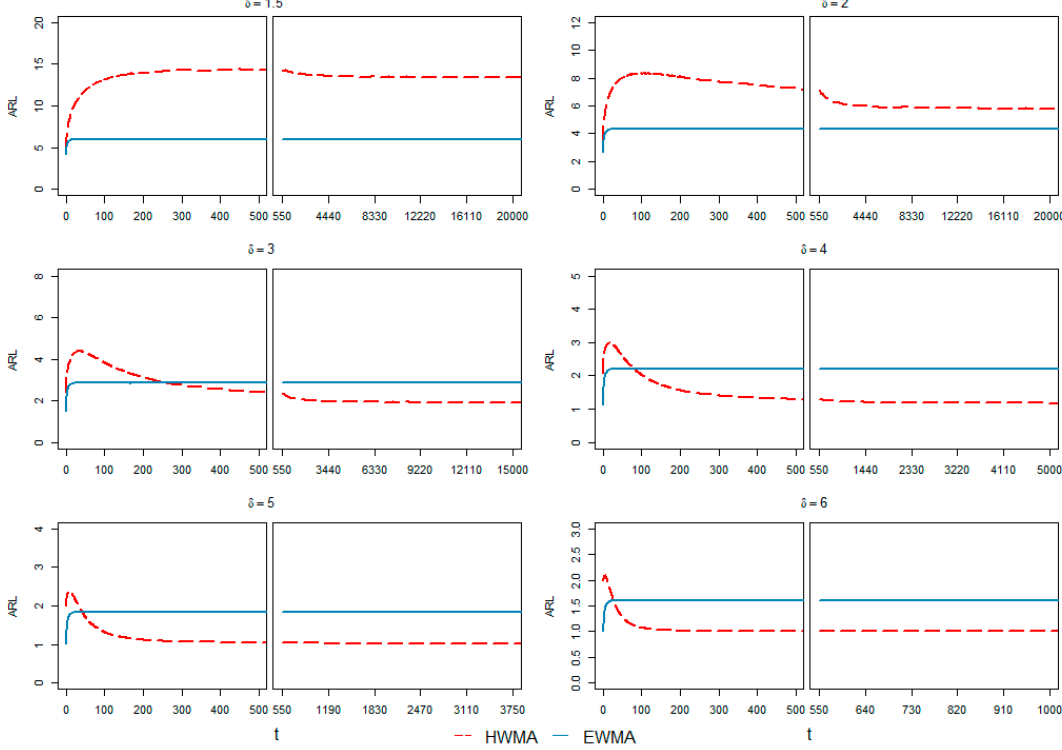
Figure 7. CED curves for the HWMA and EWMA charts under moderate to large shifts at 𝜆 = 0.1 with respect to time points (𝑡) .